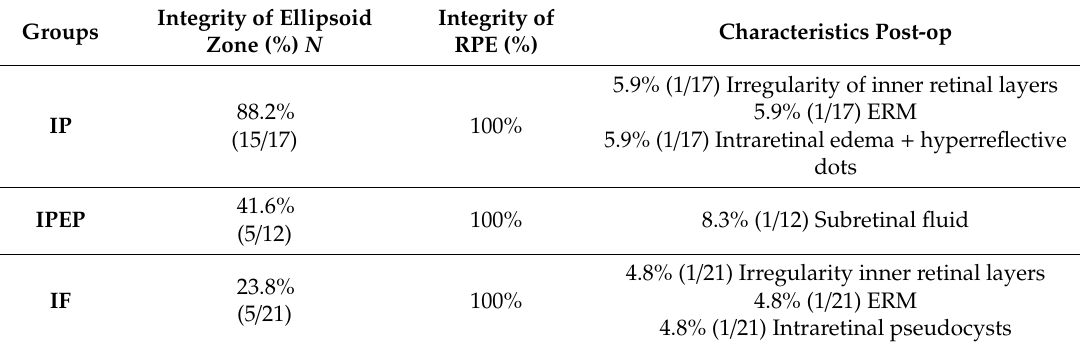
Table 6. Post-op anatomical